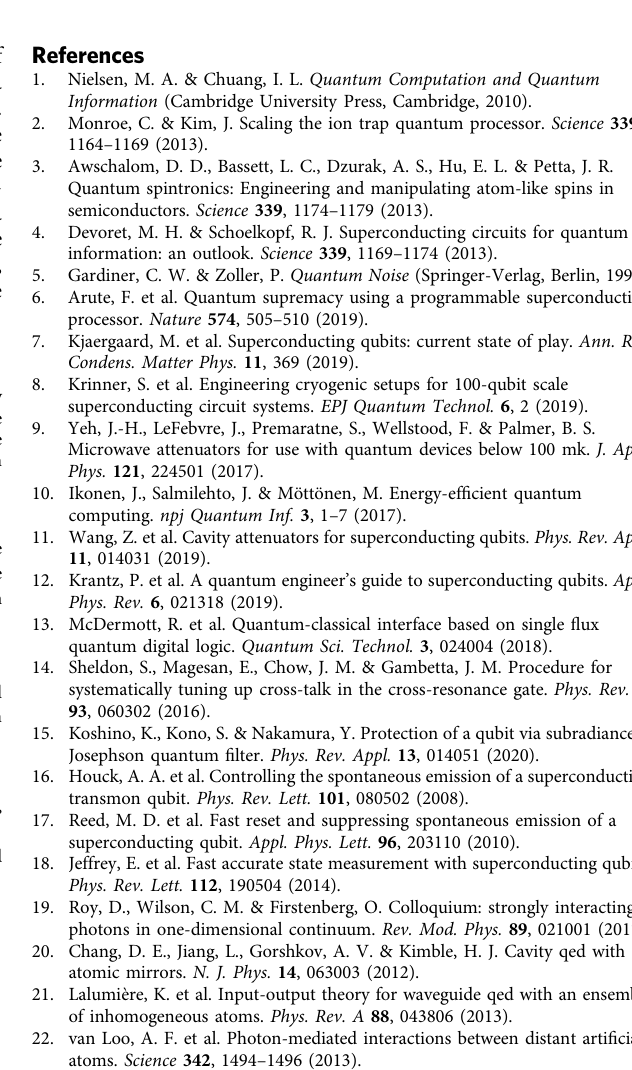
Fig. 4 Controlling the qubit in the presence of the JQF. a , b Rabi frequency and Rabi decay time of the qubit as a function of the control amplitude p ffiffiffi _ n . The top axes show the corresponding Rabi frequency of the JQF Ω f normalized by its external decay represented as the square root of the photon fl ux rate γ f . The red and blue data are the experimental results with and without the JQF, respectively. The red and blue solid lines depict numerical results ex with and without a transmon JQF, whereas the green dashed lines show simulation results using a two-level JQF. The insets are magni fi cations of the small amplitude region of the main plots. c Average gate error of the qubit as a function of the control pulse duration, obtained by randomized benchmarking. A Gaussian pulse is used for the qubit control, and the pulse interval is set to be twice the pulse duration. The black dashed line depicts the coherence limit. The error bars represent standard